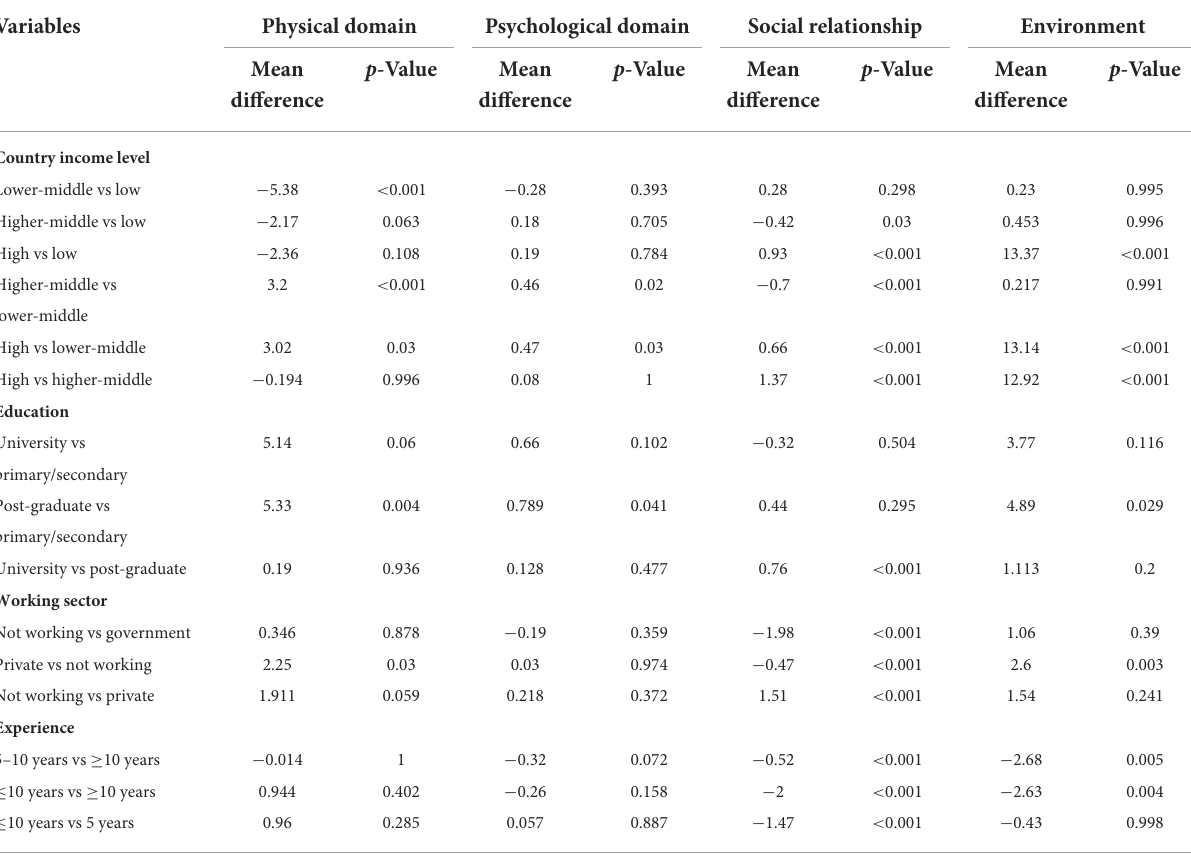
TABLE 5 Post-hoc analysis for the one-way ANOVA to differentiate among different groups across the domains of QoL.